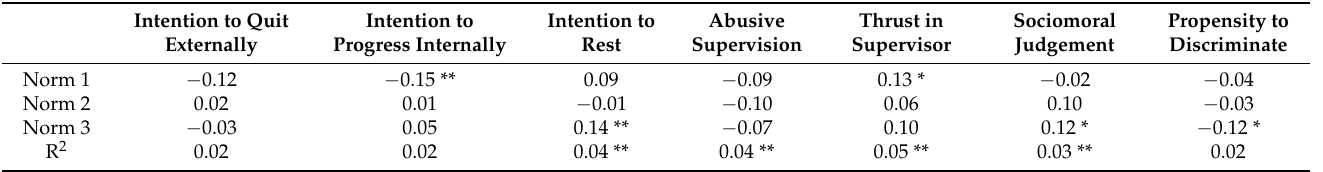
Intention to Progress Internally